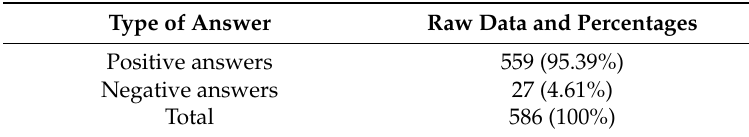
Table 5. Distribution of the answers given by male students in raw data (and % between brackets). NB: due to 2 non-answers, the total global is below 588 (42 participants × 14